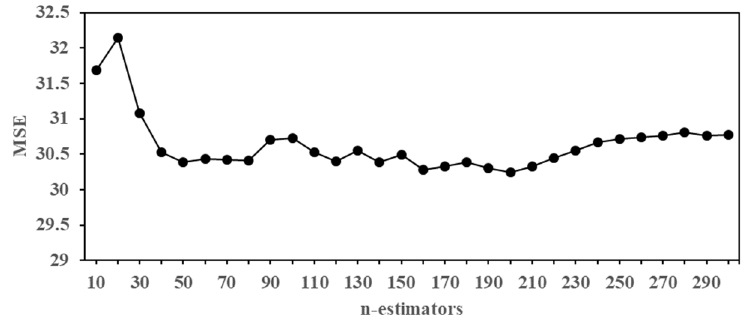
Figure 11. The mean square error (MSE) of random forest regression model of different n-estimator . Note: the range of n-estimator is from 10 to 300 and the step length is 10.